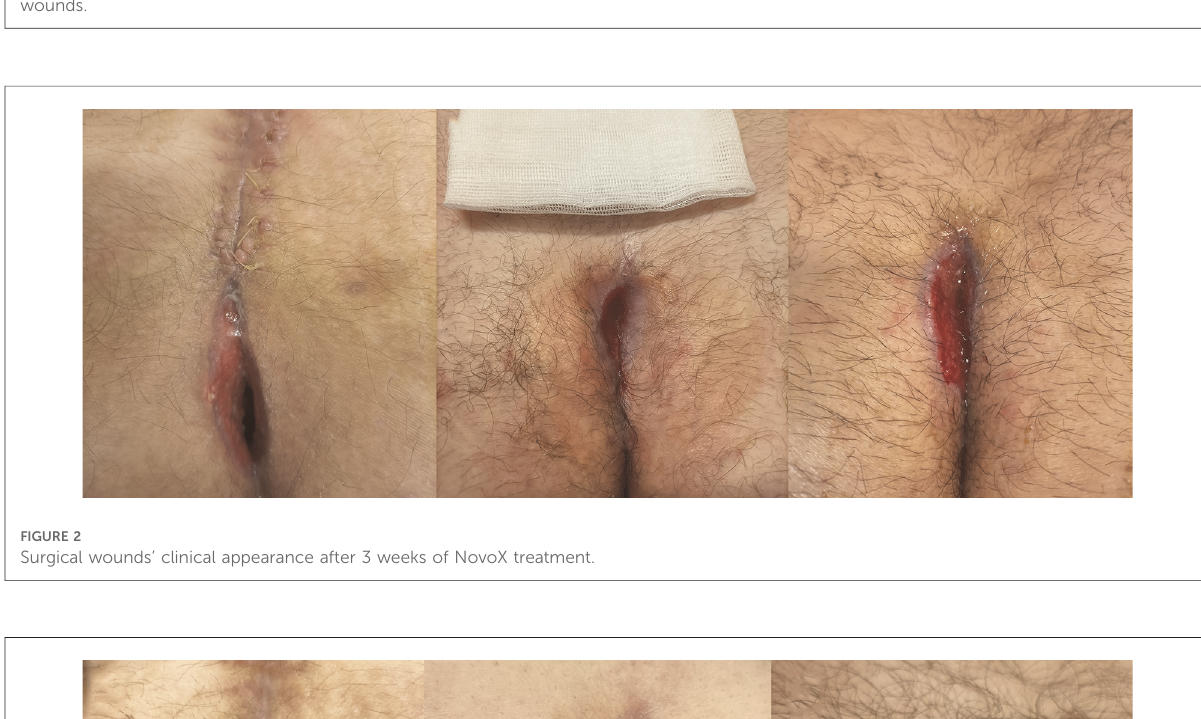
FIGURE 1 Close-up views of our three patients ’ surgical wounds immediately after open midline treatment of chronic PD. NovoX was applied directly inside the wounds.